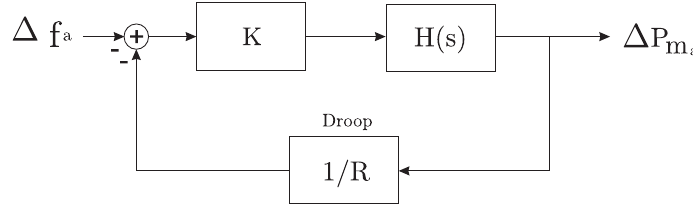
Figure 4. Block diagram of the primary frequency control of Area a